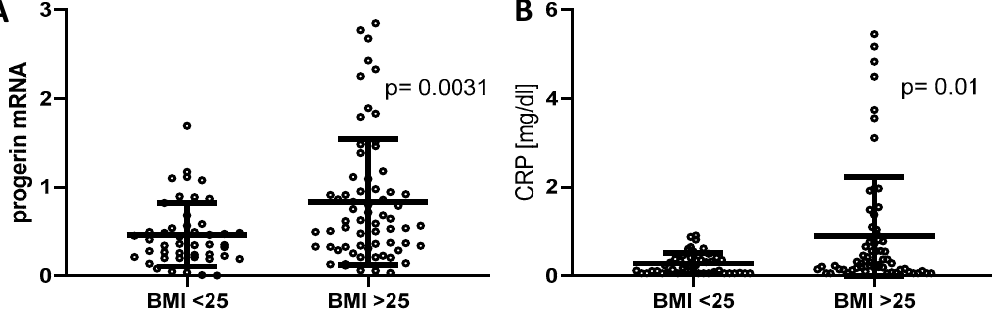
Figure 2. High Body-Mass-Index (BMI) is related to increased progerin mRNA and systemic inflammation. ( A ) Scatterplot diagram showing all individual data points; lines show mean values ± SD of progerin mRNA related to the reference gene RPL32 in normal ( n = 46) and overweight individuals ( n = 65) ( p < 0.003 between the weight groups). ( B ) Scatterplot diagram showing all individual data points; lines show mean values ± SD of hs-CRP RPL32 in normal ( n = 46) and overweight individuals ( n = 64) ( p < 0.01 between the weight